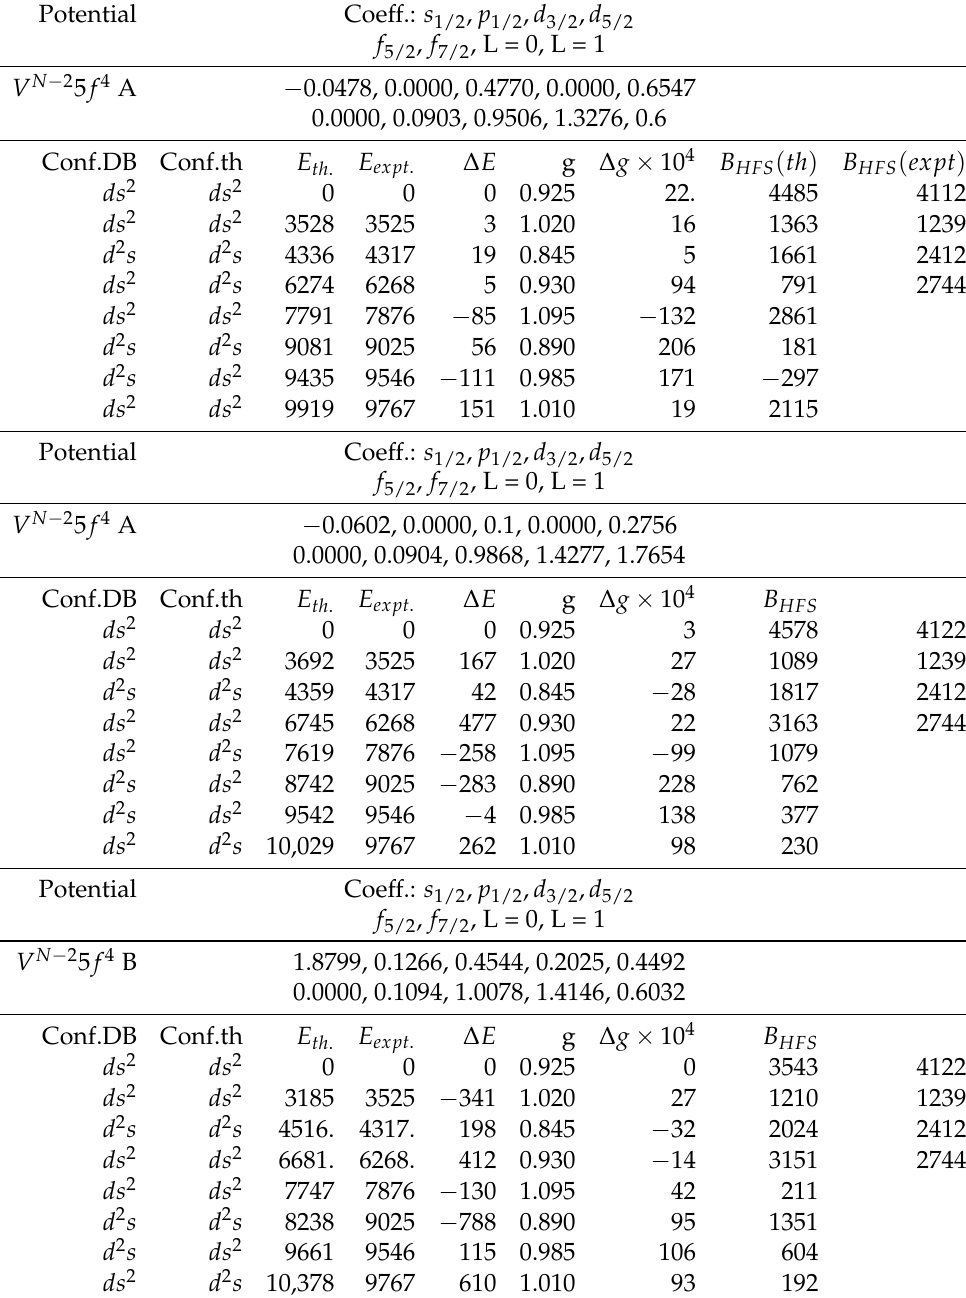
Conf.DB are configuration notations taken from Data Base [13], and Conf.th are configurations obtained by CI-MBPT; g is Landé g -factor from Data Base [13]. B HFS (th) and B HFS (expt) are current CI-MBPT and experimental [39] quadrupole hyperfine constants (in MHz),